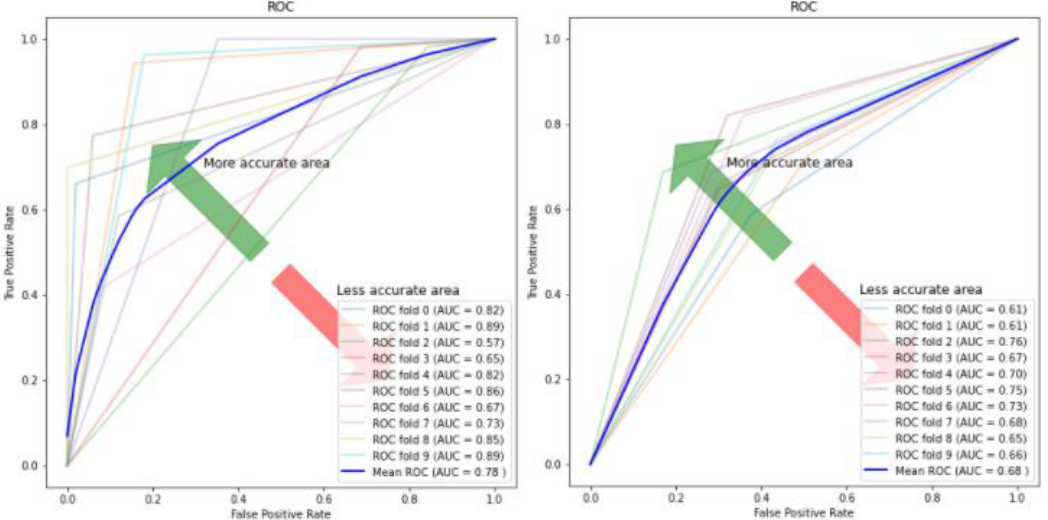
Figure 14. ROC curve and AUC values for autoencoder–CNN ( Left ) and CNN ( Right ). ROC: Receiver Operating Characteristics; AUC: Area under the Curve.